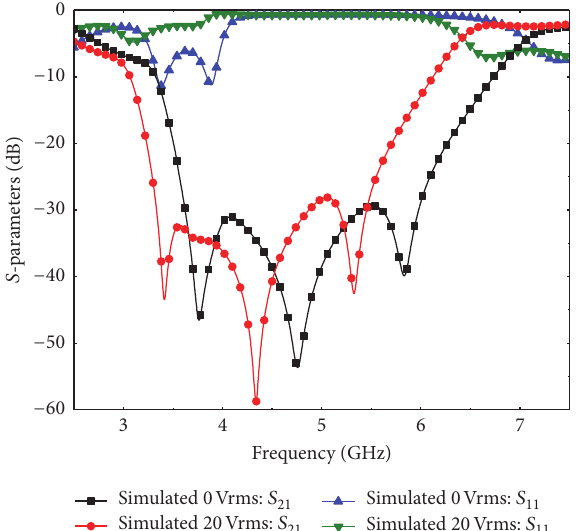
Figure 6: Simulated S -parameters of the proposed filter when the substrate LC is